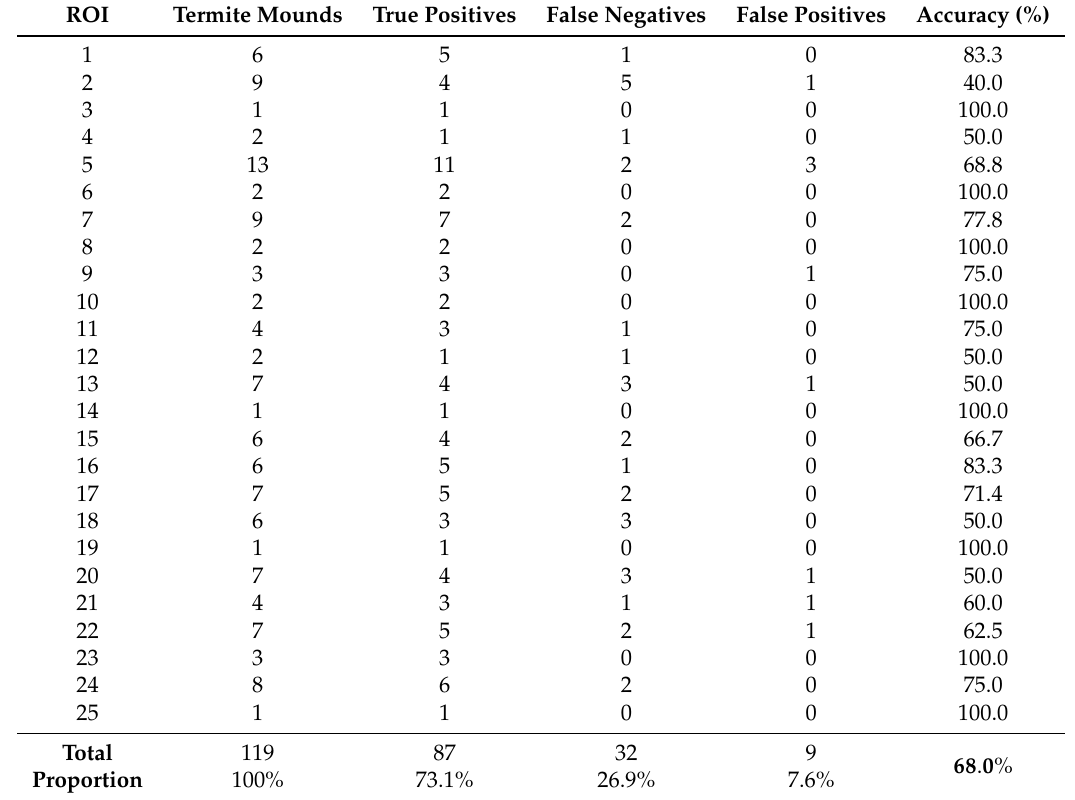
Table 1. Accuracy results of the proposed